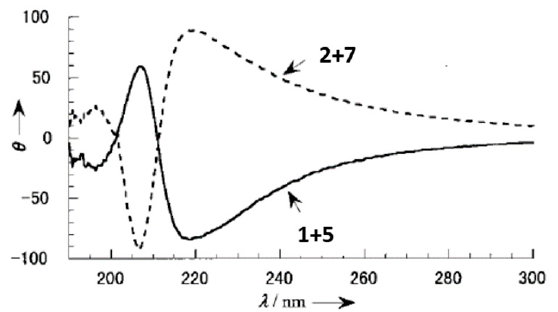
Figure 5. CD spectra of 1 + 5 (1:1 wt %) and 2 + 7 (1:1 wt %) organogels obtained from acetonitrile: 25 °C, total gelator concentration: 4.18 × 10 − 3 mol L − 1 . Adapted with permission from Wiley [31]. The transcription of the chiral, helical structures of the organogels into silica gel was achieved by sol-gel polycondensation of tetraethoxysilane (TEOS). In all cases, the left- and right-handed structures of the silica could be created by transcription of the left- or right-handed structures of the organogel systems.